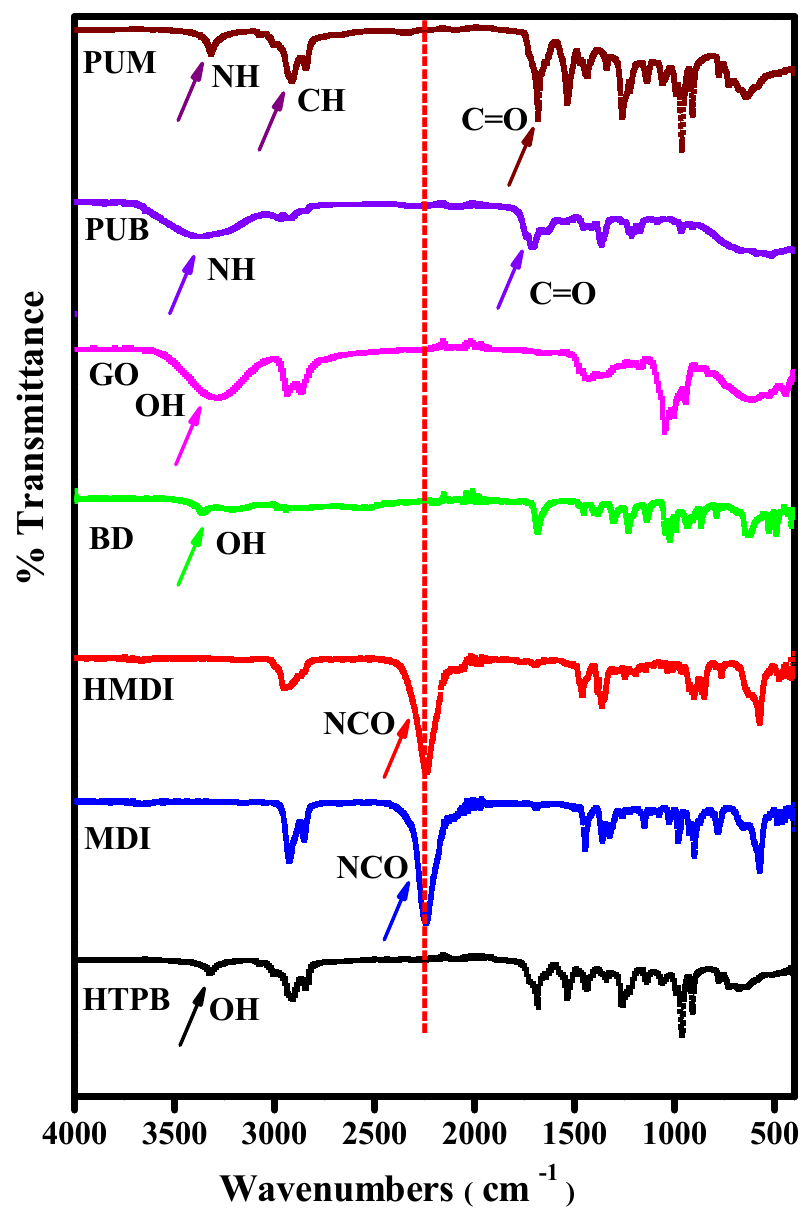
Figure 2. Fourier transform infrared (FTIR) spectra of monomers, polymer, and composite: HTPB (macrodiol), MDI and HMDI (diisocyanates), BD (chain extender), GO (reinforcing agent), PUB (blank polyurethane), and PUM (polyurethane composite).